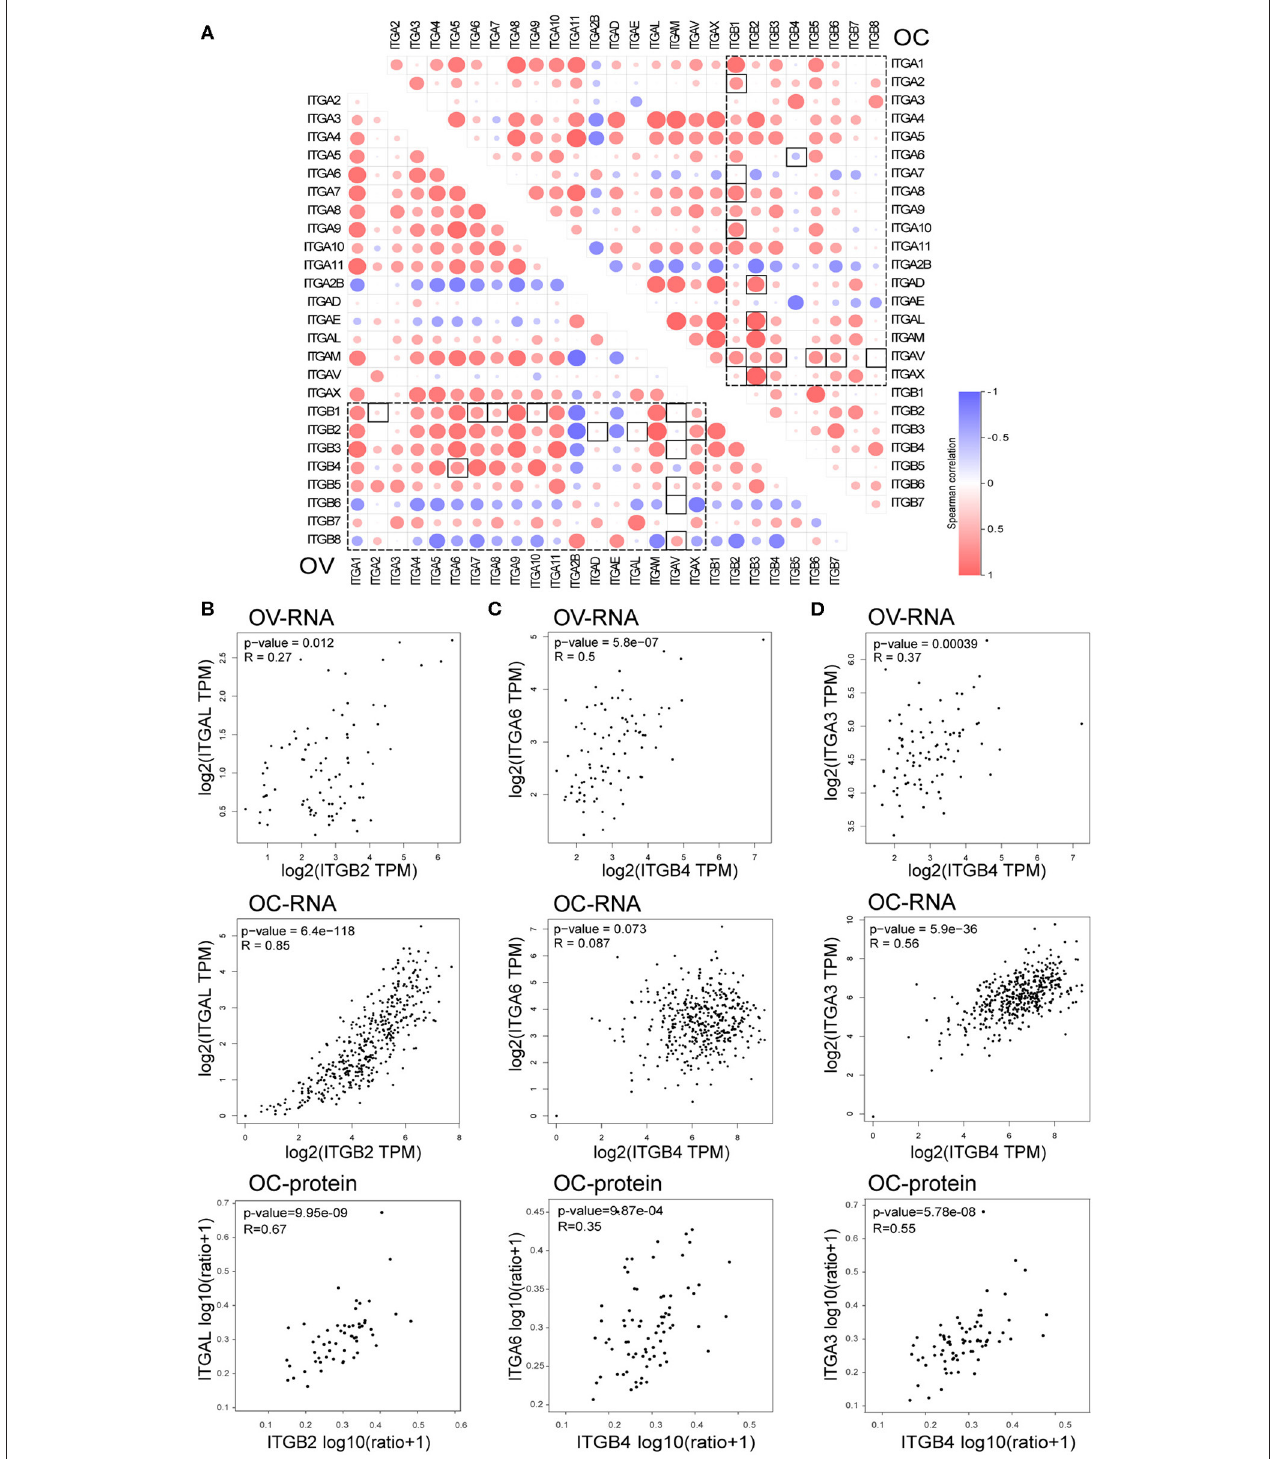
FIGURE 7 | Correlation between integrin genes in OC and normal ovary tissue. (A) Correlation between ITGAs and ITGBs mRNA expression in OC and normal ovary tissue (box with dash lines), correlation ratio alterations between OC and normal ovary tissue were highlighted with a solid line frame. (B) Correlation of ITGB2 and ITGAL mRNA expression in normal ovary (up) and OC (down) tissue, correlation of ITGB2 and ITGAL protein level in OC tissue (bottom). (C) Correlation of ITGB4 and ITGA6 mRNA expression in normal ovary (up) and OC (middle) tissue, correlation of ITGB4 and ITGA6 protein level in OC tissue (bottom). (D) Correlation of ITGB4 and ITGA3 mRNA expression in normal ovary (up) and OC (middle) tissue, correlation of ITGB4 and ITGA3 protein level in OC tissue (bottom).